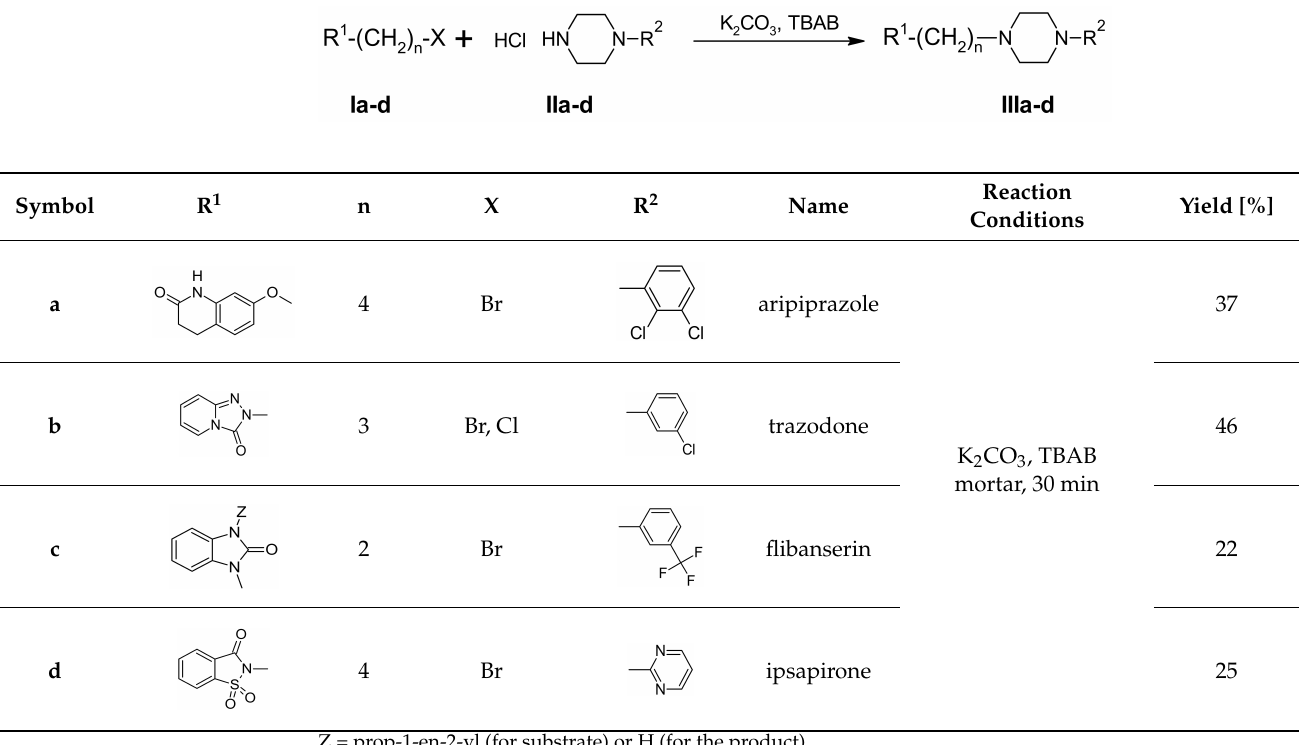
Table 1. Synthesis of aripiprazole, trazodone, fibanserin and ipsapirone in the presence of potassium